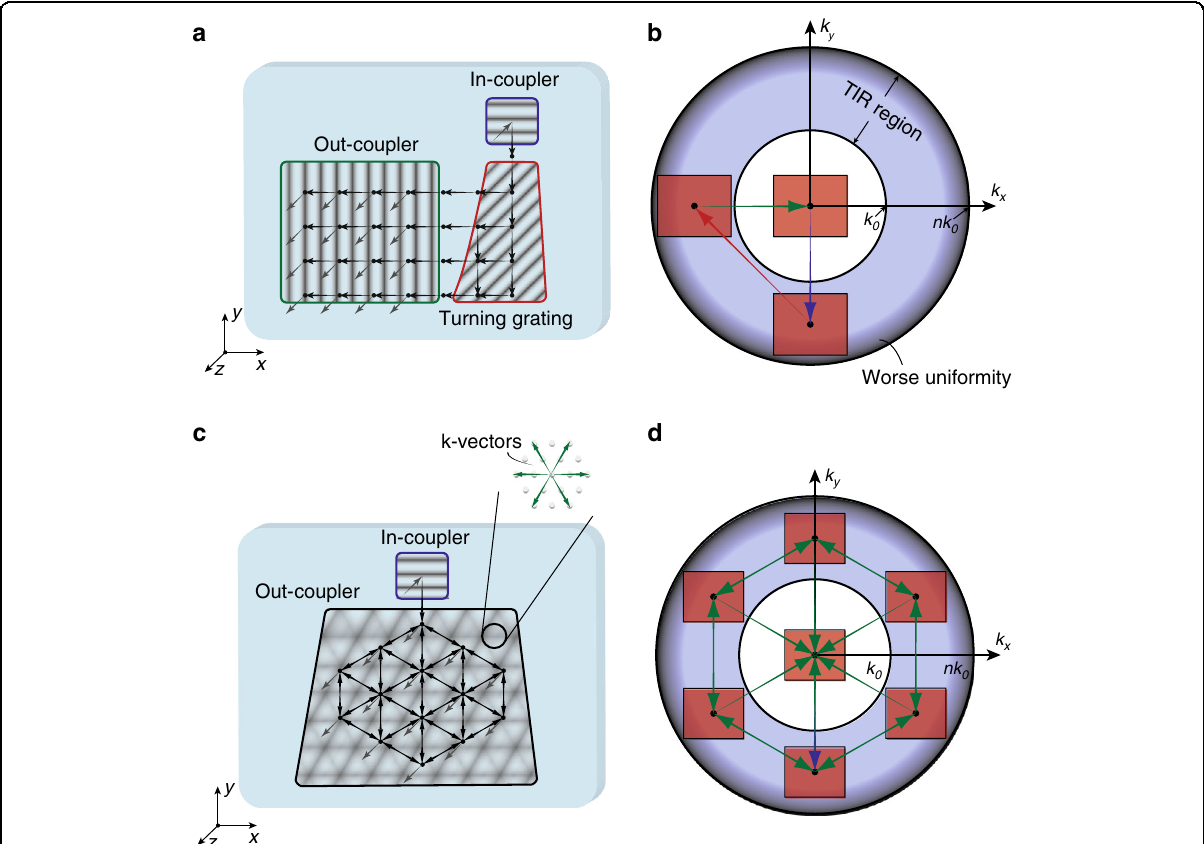
Fig. 13 Schemes for 2D EPE. a Schematic of 2D EPE based on two consecutive 1D EPEs. Gray/black arrows indicate light in air/TIR. Black dots denote TIRs. b k-diagram of the two-1D-EPE scheme. c Schematic of 2D EPE with a 2D hexagonal grating d k-diagram of the 2D-grating